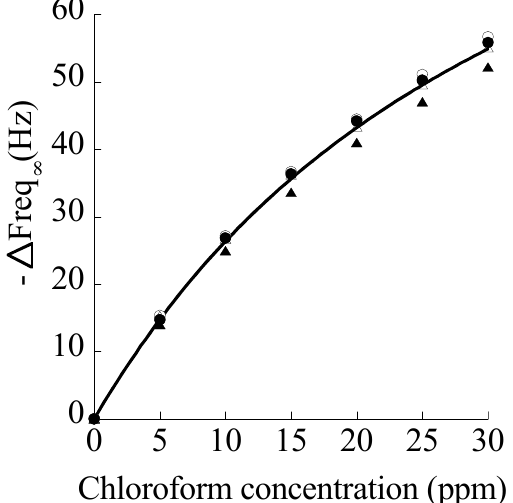
Figure 13. Plot of static response of the sensor as a function of chloroform concentration. Solid line represents data fitting with Equation 5.